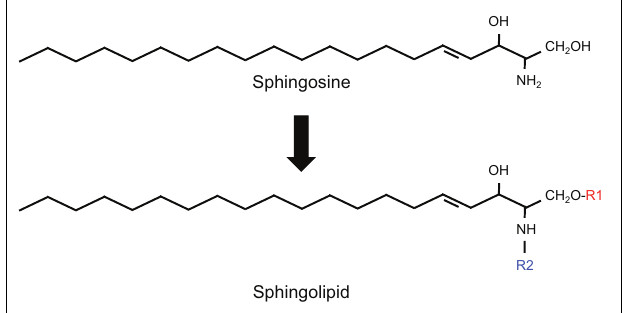
FIGURE 1 | Structure of sphingolipids . In sphingolipids, the hydrophobic region consists of a longchain sphingoid base with generally 18 carbons, such as sphingosine, which is linked to the acyl group of a fatty acid via an amide bond (R2).The hydrophilic region (R1) consists in the simplest case of a hydroxyl group in the case of